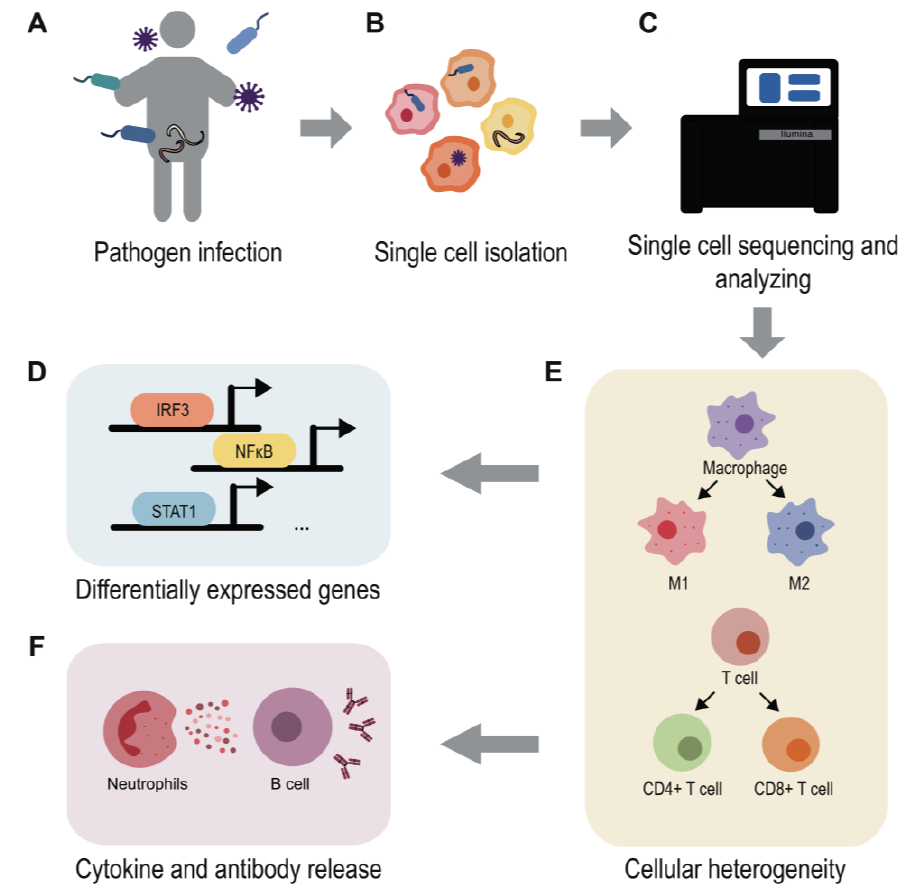
FIGURE 2: Using single-cell RNA-seq to understand host- pathogen interactions. Patho- gens like bacteria, viruses, fungi and parasites can infect hosts and cause various infectious diseases (A) . Using scRNA-seq methods enable the study of host and pathogen interactions at a high-resolution level (B-C) . The single cell transcriptomes reveal the differentially gene expression map during infec- tion (D) , demonstrate the cell heterogeneity and immune cell development (E) , uncover the mechanism behind the inflam- matory and anti-microbial re- sponse (F) . The application of scRNA-seq highly contributes to infection